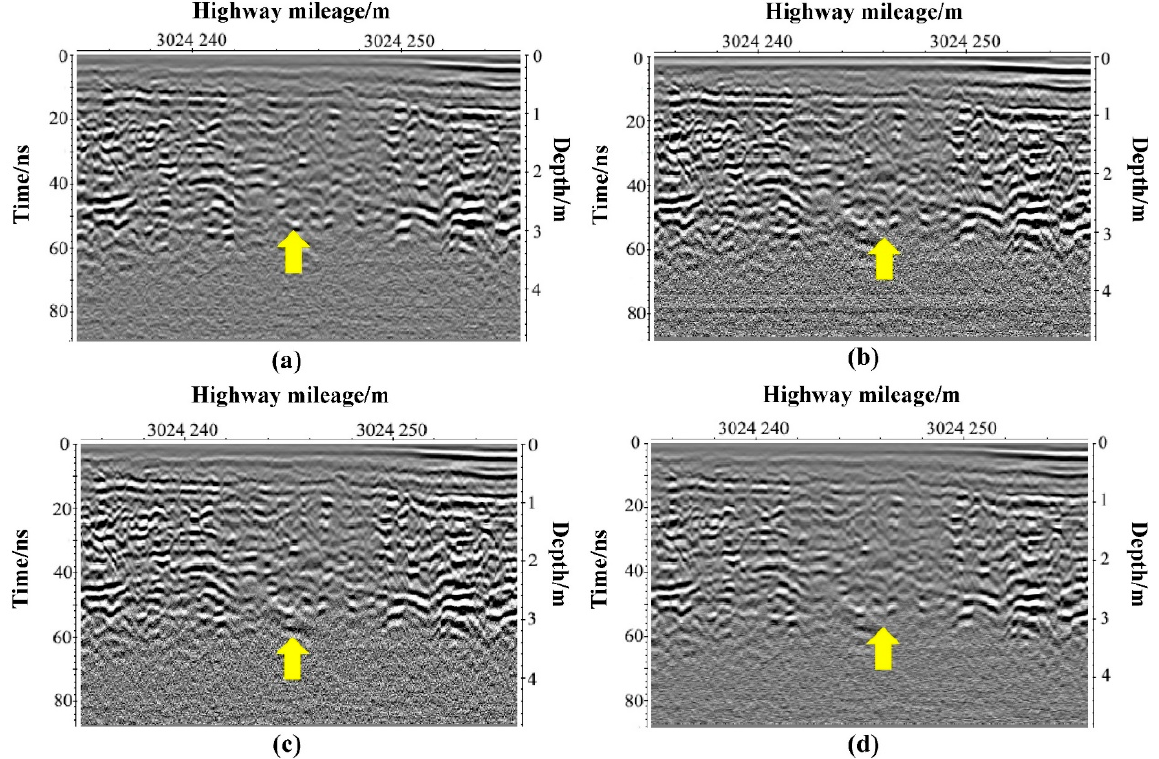
14 of 22 Figure 11. GPR images of an abnormally dense block-stone layer: ( a ) K 3024 + 235 to K3024 + 256; ( b ) K 3024 + 452 to K3024 + 474. The yellow dashed box shows the abnormal area of the block- stone layer, the red dotted line indicates the boundary between the sand-gravel layer and the block- stone layer, and the yellow arrow is used to facilitate reading . GPR images cannot exhibit low reflections due to the different data processing steps,